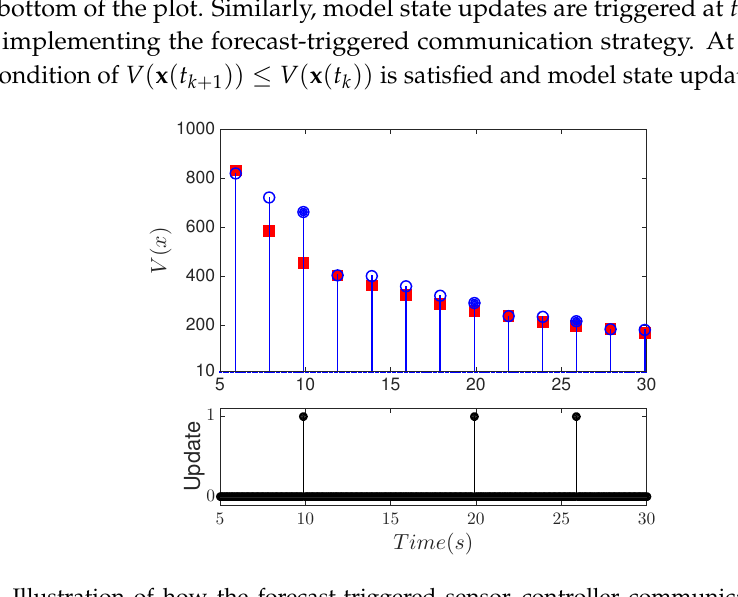
Figure 4. Illustration of how the forecast-triggered sensor–controller communication strategy is implemented. The top plot depicts current values of the Lyapunov function (red squares), projected values of the Lyapunov function (blue circles) and update events (solid blue dots) at different sampling times. The bottom plot depicts the time instances when the model state is updated.